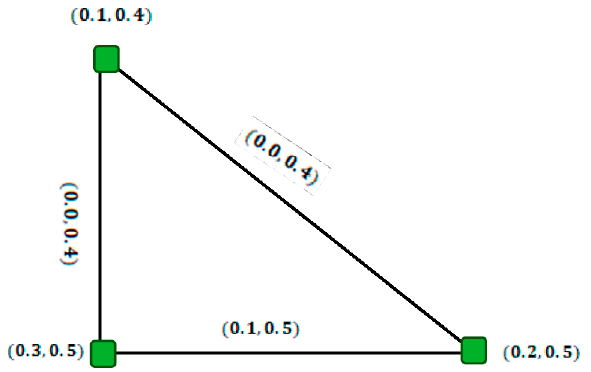
Figure 3. Intuitionistic fuzzy graph (IFG) compatible with Definition 2.